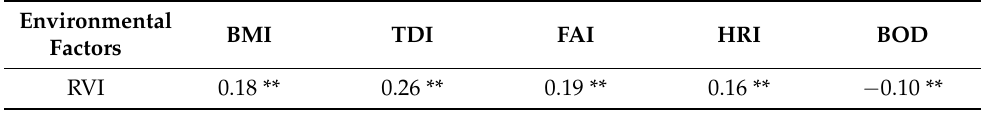
Table 4. Correlations (Pearson) between riparian vegetation index and index based on other taxa and BOD. BMI: Benthic Macroinvertebrates Index, TDI: Trophic Diatom Index, FAI: Fish Assessment Index, HRI: Habitat Riparian Index, BOD: Biochemical Oxygen Demand.